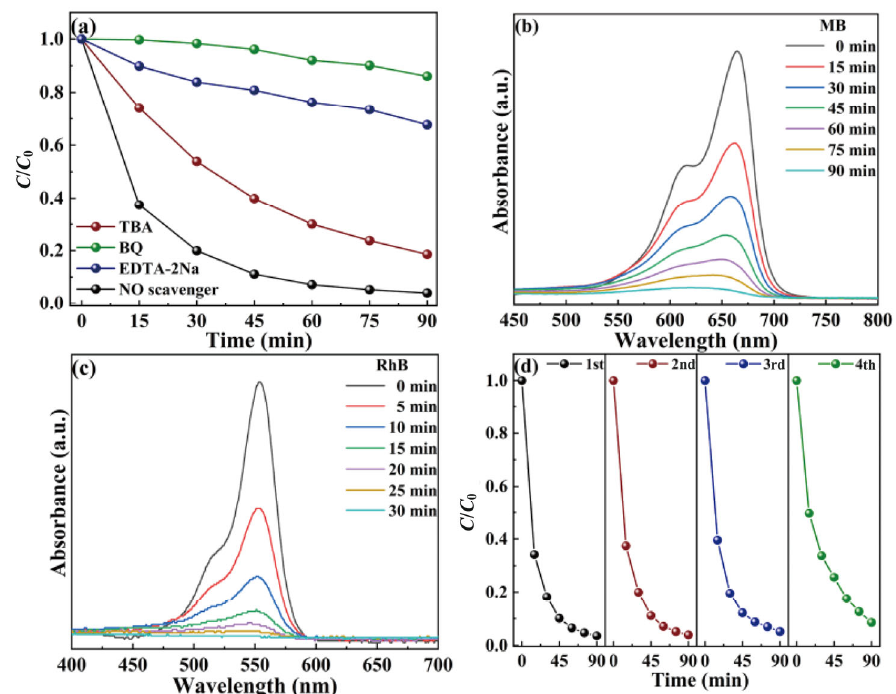
Fig. 8 (a) Piezo-photocatalytic degradation of MO by poled BaTiO 3 –0.6CuO heterostructures in the presence of holes, electron hydroxyl radicals, and superoxide radical scavengers. UV–Vis absorption spectra of (b) methylene blue (MB) and (c) rhodamine B (RhB) aqueous solutions at different reaction time over poled BaTiO 3 –0.6CuO heterostructures. (d) Relative intensity of the maximum absorption at 464 nm as a function of reaction time in four recycling